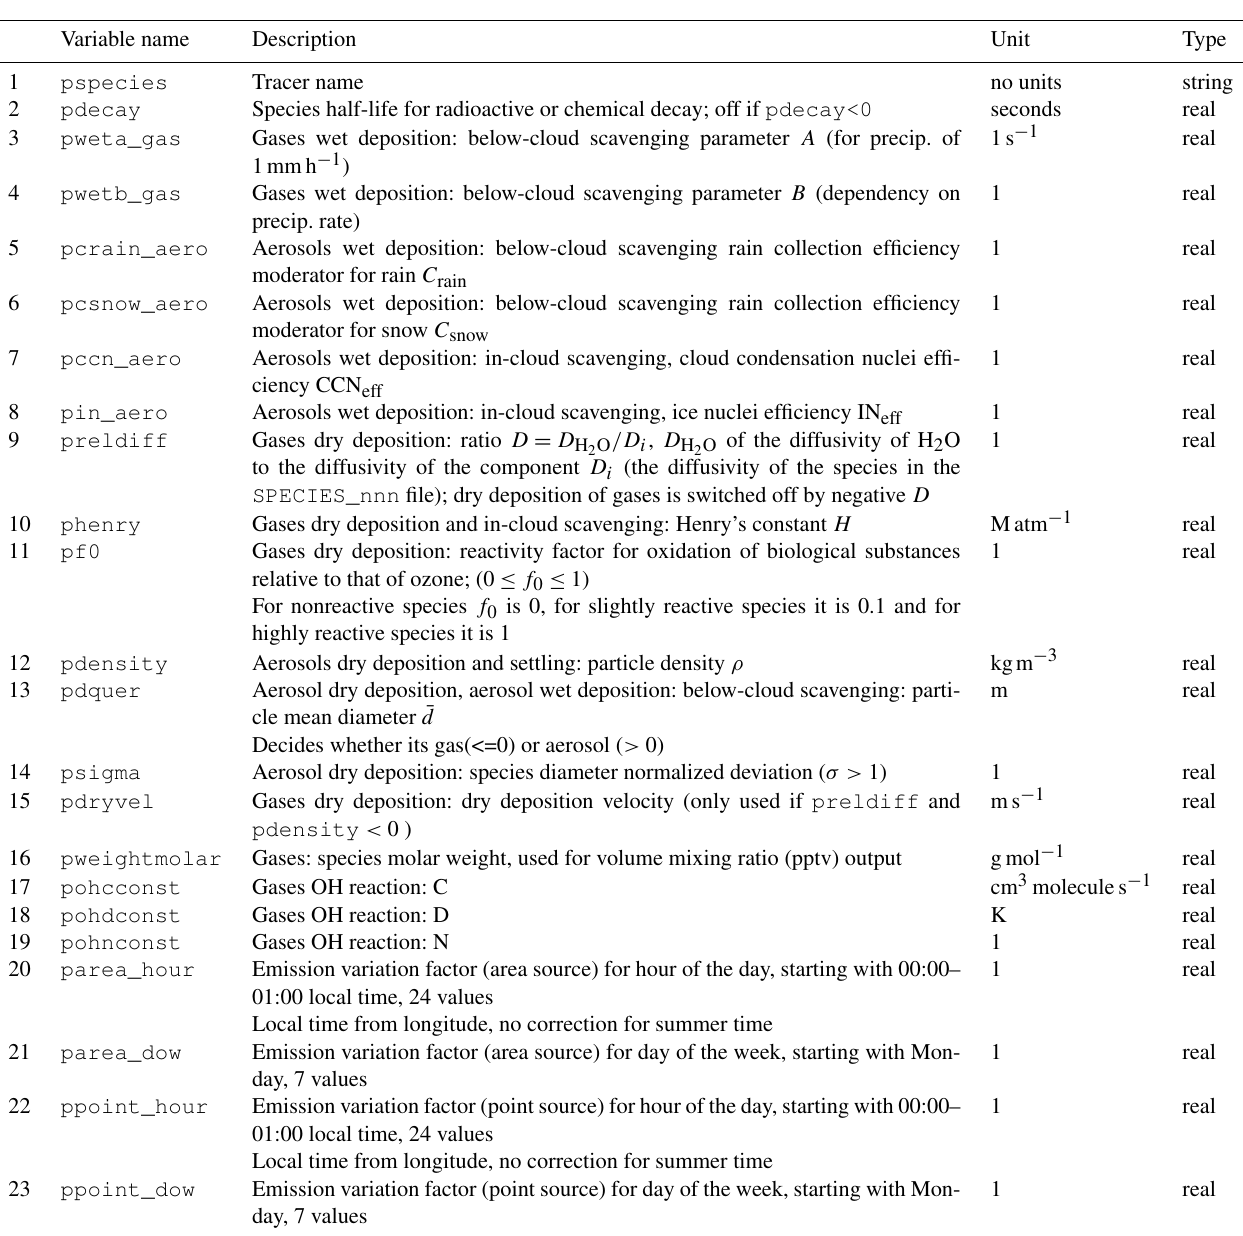
Table 10. FLEXPART variables set in the user input file SPECIES_nnn for species number nnn . Note that the variable names given in the input namelist are the same as used subsequently in FLEXPART but with a prepended letter p (for parameter). For instance, pspecies corresponds to species